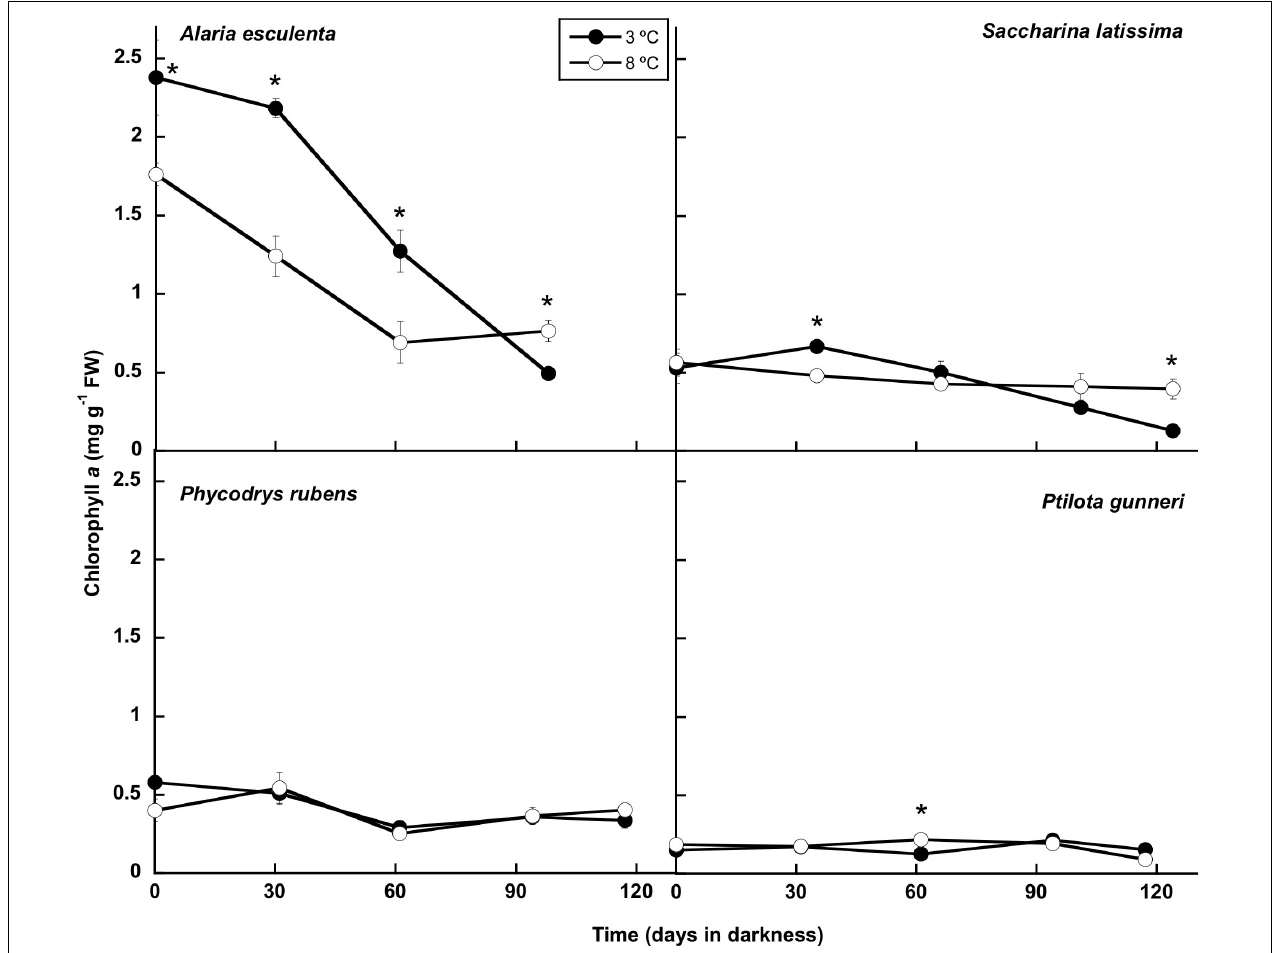
FIGURE 6 | Chlorophyll evolution during the 16 weeks of incubation in darkness of Alaria esculenta , Saccharina latissima , Phycodrys rubens , and Ptilota gunneri at two different temperatures. Data are mean of 5 replicates (error bars for standard deviation). Significant differences between temperatures marked with an asterisk.